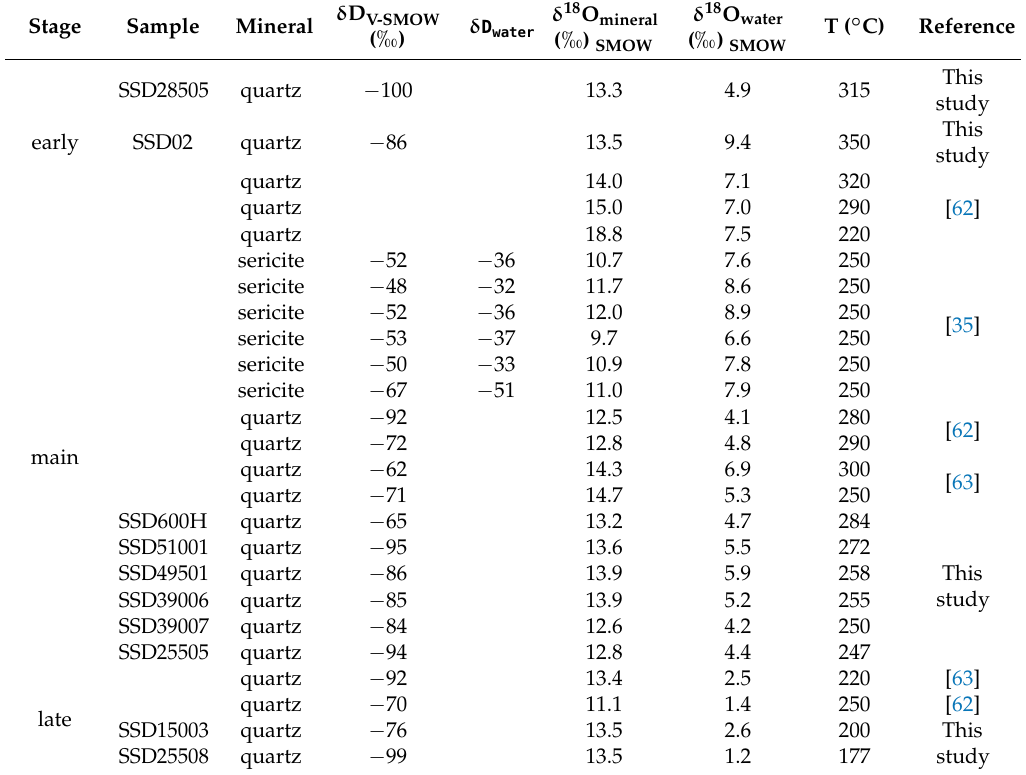
Table 3. Oxygen and hydrogen isotope analyses in the Sanshandao gold deposit.